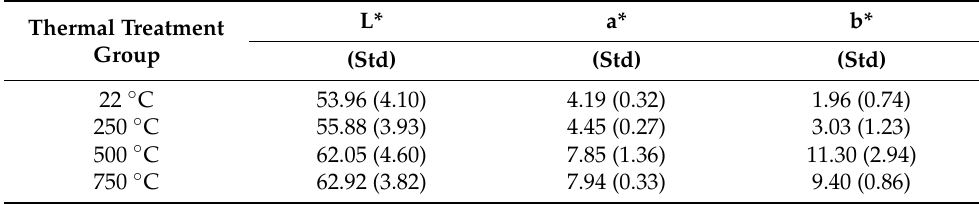
Figure 4. Spectral reflectance of the reference sample and heat-treated samples. Table 2 shows the colorimetric data of the room temperature and heat-treated granite samples used in the CIE L*a*b* system. The data reflects the trends in a color change from 22 ◦ C to 750 ◦ C (Figure 5). Table 2. CIE L*a*b* colorimetric data of granite samples at 22 ◦ C and 250 ◦ C, 500 ◦ C, 750 ◦ C of heat-treatment.